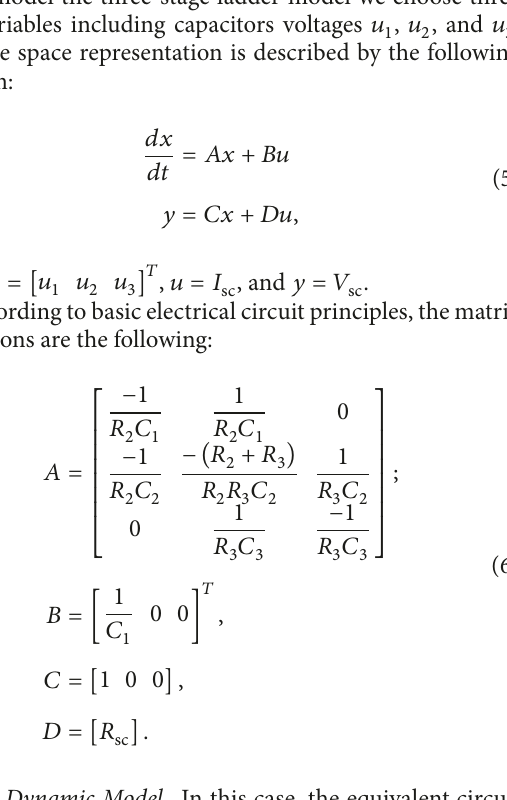
Figure 6: The dynamic model.